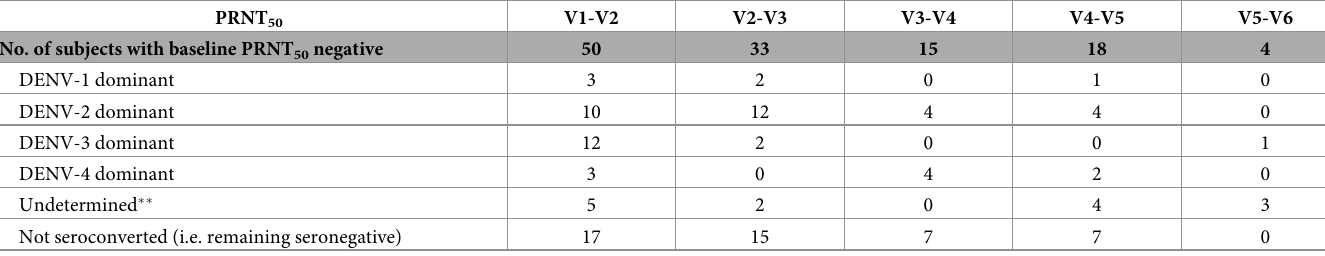
Not seroconverted (i.e. remaining